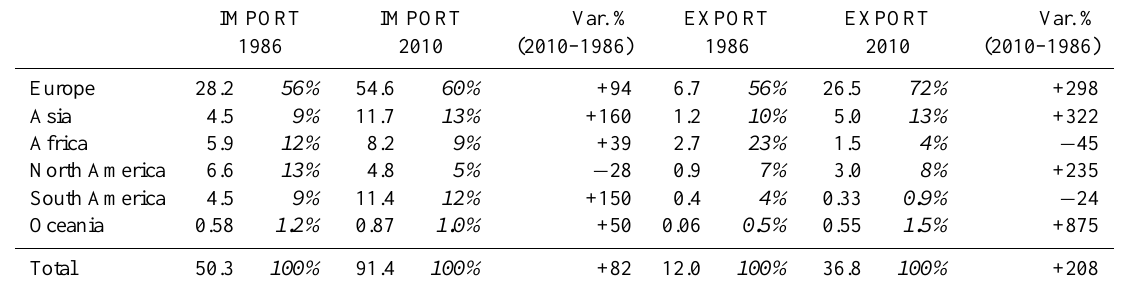
Table 1. Volumes of virtual water imported and exported by Italy in 1986 and 2010 grouped by world regions (in km 3 yr − 1 ) and percentage variation in time. Percentages in the import/export columns (in italic) are calculated with respect to the total value in the last row. IMPORT IMPORT Var. %